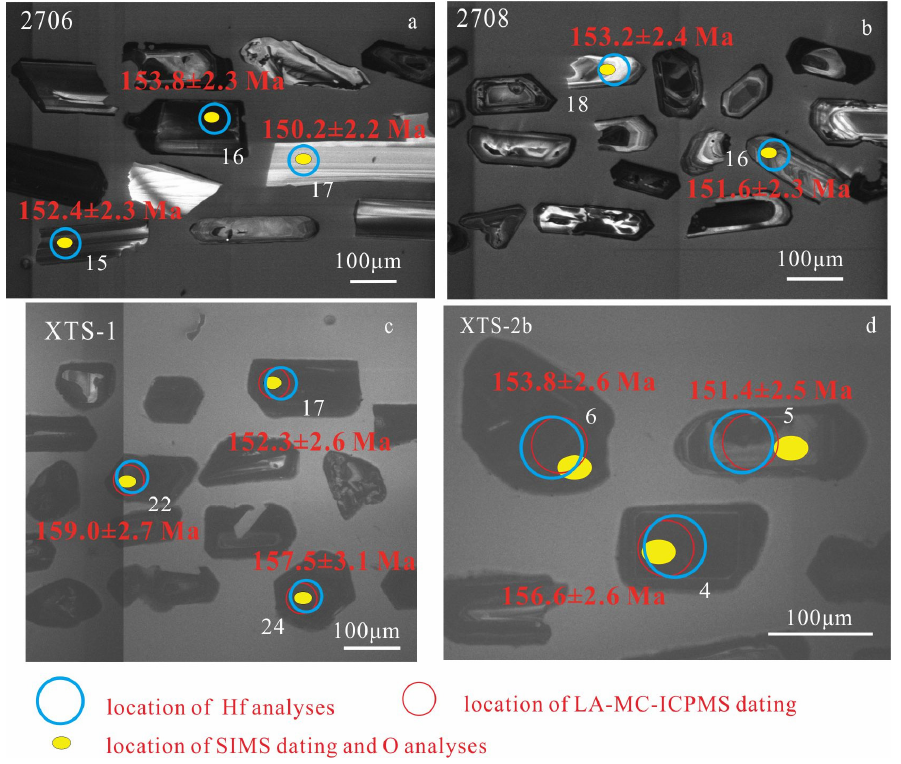
Figure 4. Cathodoluminescence (CL) images of representative zircons from ( a ) biotite monzogranite, ( b ) biotite granite, and ( c , d ) microgranlar enclaves. The circles show ing the locations of in situ U-Pb, Hf, and O isotopes analyses.